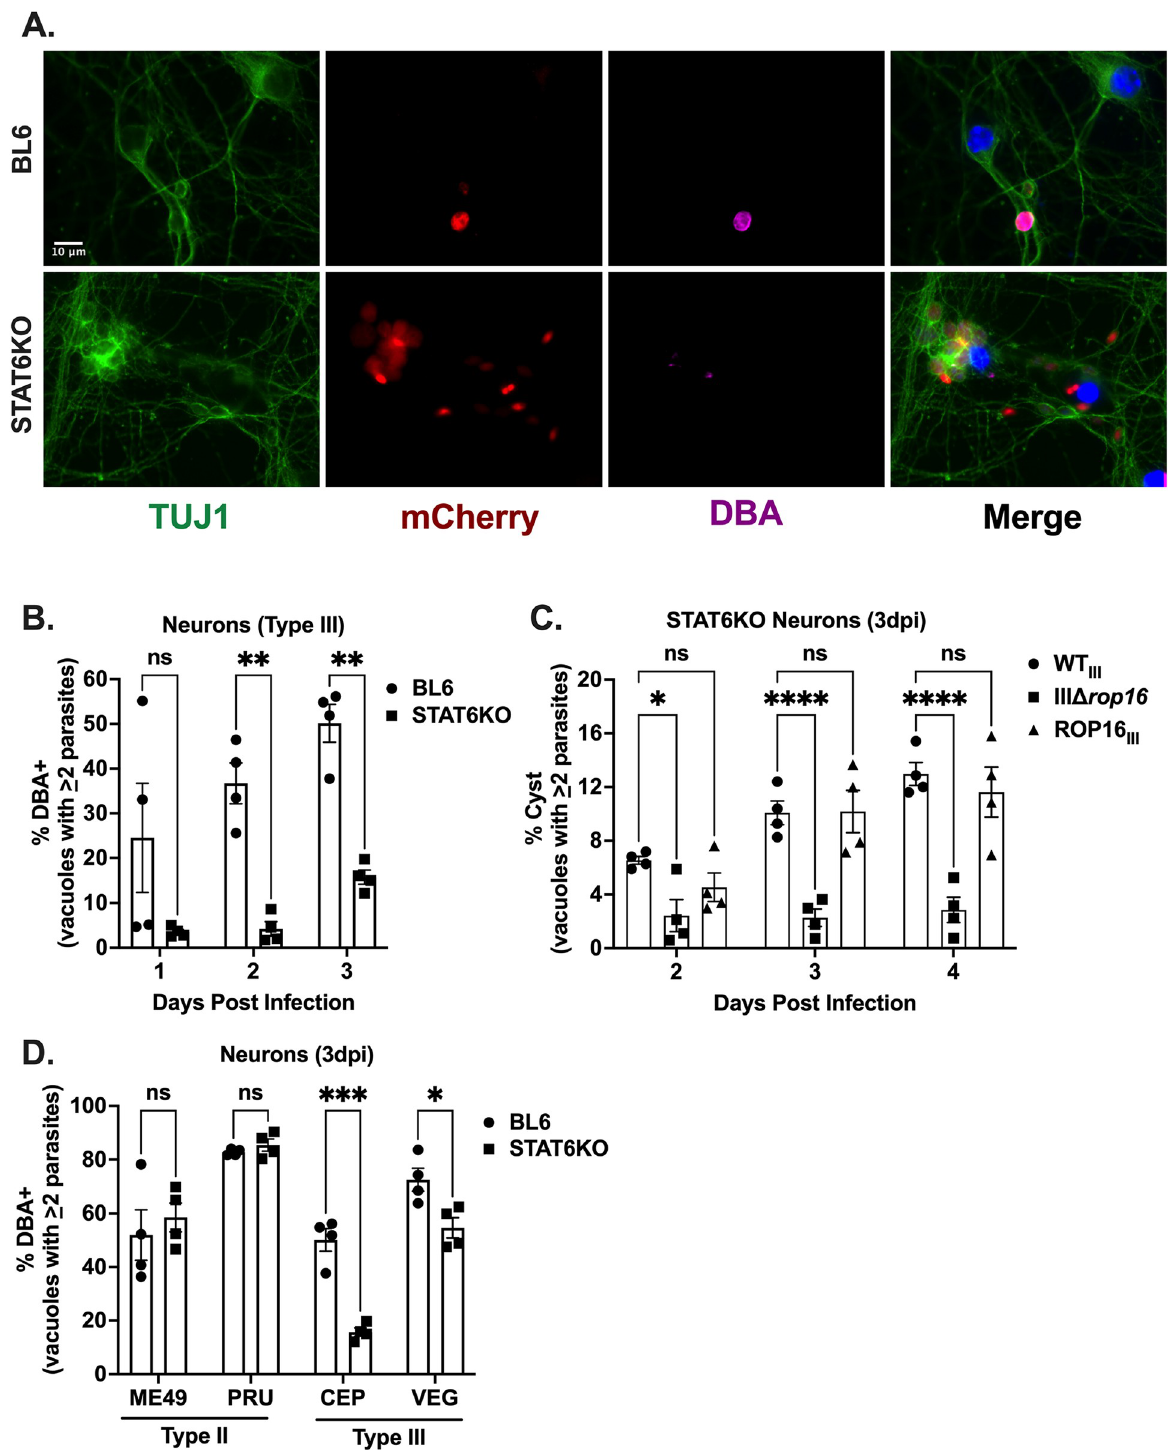
Fig 4. STAT6 facilitates encystment of type III, but not type II parasites, in vitro . (A) IFA of cyst assay. BL6 (control) or STAT6KO PNCs were infected with WT III (MOI 0.1) for 2 dpi. Images depict anti-TUJ1 (green, neurons), mCherry (red, parasites), DBA (magenta), and DAPI (blue). Scale bar = 10 μ m. (B) Quantification of encystment of WT III parasites overtime in identified PNCs. (C) Quantification of encystment of WT III , III Δ rop16 , and ROP16 III parasites overtime in STAT6KO PNCs. (D) Quantification of encystment in identified PNCs at 3 dpi for listed type II and type III strains. (B-D) Bars, mean ± SEM. N = 5 wells/experiment, 4 experiments total. (B, D) * p � 0.05, ** p � 0.005, *** p � 0.0005, ns = not